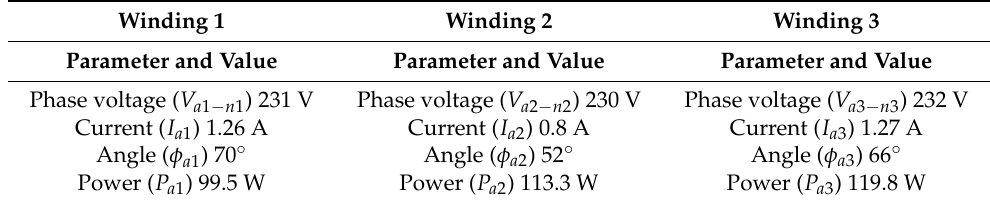
Table 7. The obtained values of the non-load test carried out by independent sets at the asymmetrical nine-phase IM.